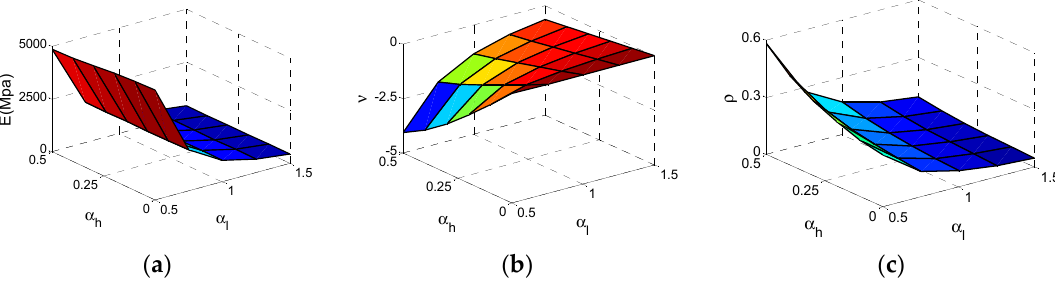
Figure 11. The Surfaces of effective properties for Type C cell: ( a ) effective Young’s modulus E ; ( b ) effective Poisson ratio v ; ( c ) relative density ρ .